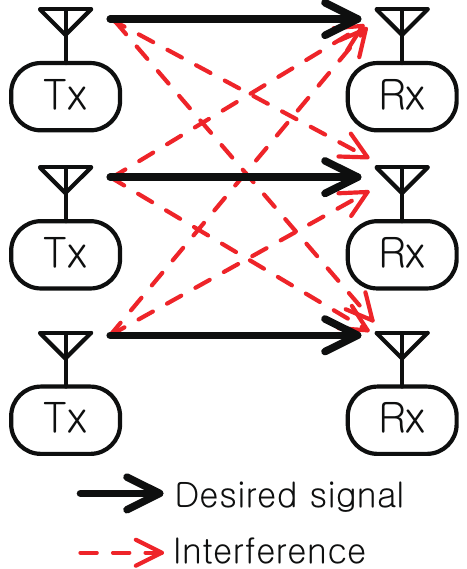
Figure 1. Schematic diagram of interference channels with three ( K = 3) transmitter–receiver